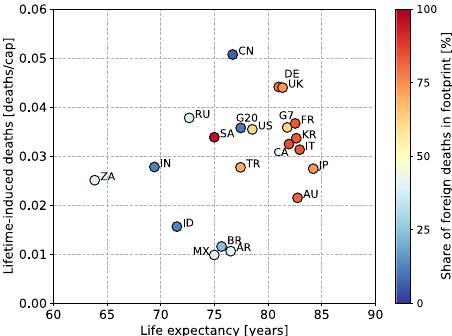
Fig. 6 Relationship between life expectancy, PM 2.5 -related premature deaths induced by lifetime consumption per capita and percentage of foreign deaths in PM 2.5 premature death footprint in each G20 nation.